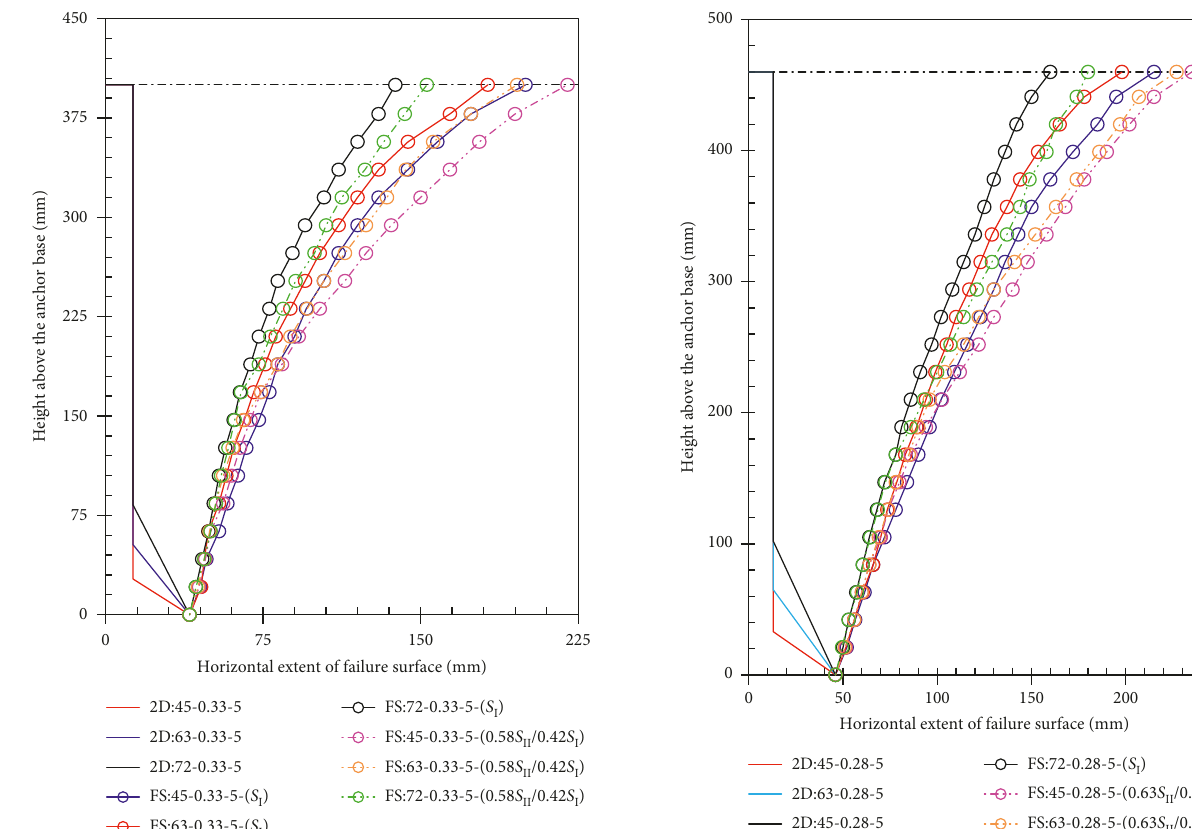
Figure 12: Comparison of FS:45-0.33-5-( S I ) and FS:45-0.33-5- (0.58 S II /0.42 S I ), FS:463-0.33-5-( S I ) and FS:63-0.33-5-(0.58 S II / 0.42 S I ), and FS:72-0.33-5-( S I ) and FS:72-0.33-5-(0.58 S II /0.42 S I ). Figure 13: Comparison of FS:45-0.28-5-( S